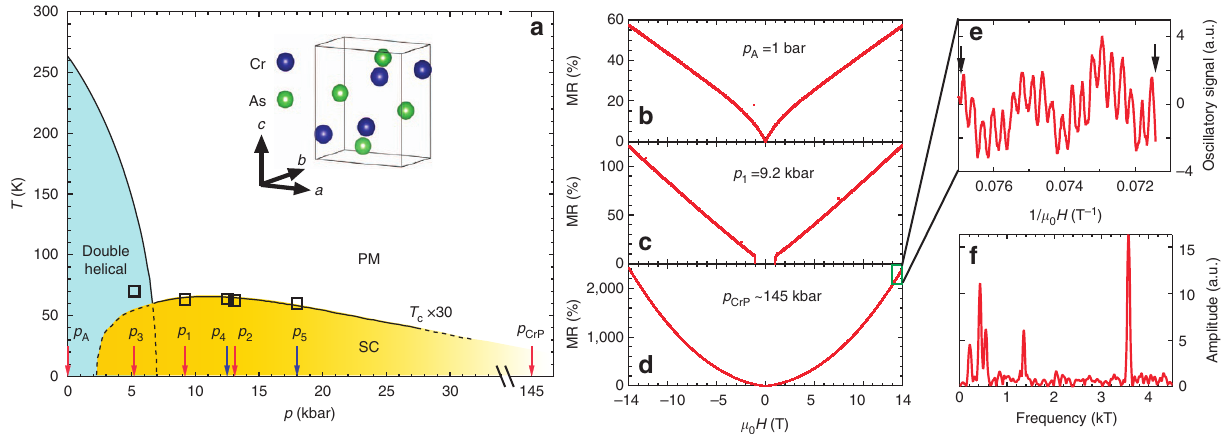
Figure 1 | Transverse magnetoresistance in pressure-tuned CrAs. ( a ) Schematic temperature–pressure phase diagram showing the helimagnetic region, the superconducting region (SC) and the paramagnetic region (PM), constructed using the data in ref. 14. The area bounded by dashed lines indicates the region with coexistence of magnetism and superconductivity. The open squares denote the experimental data of the current work, which are consistent with the previously published data 14,15 . For clarity, the values of T c are multiplied by 30. The position of CrP is determined by taking into account the chemical pressure effect of P on CrAs. The crystal structure of CrAs, prepared using VESTA 42 , is shown in the inset. ( b – d ) Magnetoresistance, defined as MR ¼ [ r ( H ) (cid:2) r (0)]/ r (0) (cid:3) 100%, from (cid:2) 14 to 14T at p A , p 1 , and p CrP , collected at 25.7, 15.5 and 16.2mK, respectively. For the data collected in the superconducting state, the magnetoresistance is calculated using a zero-field resistivity r (0) estimated from a smooth extrapolation of the data above H c2 . ( e ) High-field magnetoresistance in CrP, shown as the green rectangle in d , with steep background subtracted. The left and the right arrows are at 13 and 14T, respectively. Clear Shubnikov–de Haas oscillations can be seen. ( f ) Fast Fourier transform of the oscillatory signal in e from 8 to 14T.